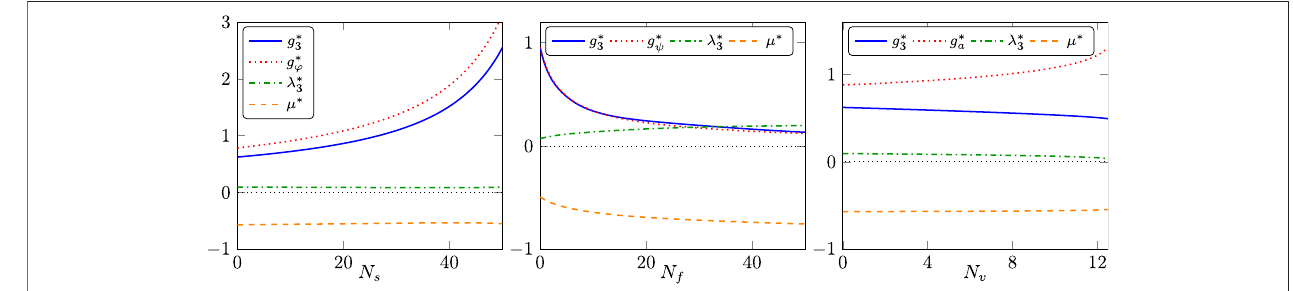
FIGURE9| Fixed-pointvaluesofthe fl uctuationcouplingsasafunctionofthenumberofscalar(left),fermion(middle),andgauge fi elds(right).Alltruncationsinclude thegravitontwo-andthree-pointfunctionaswellastherespectivegraviton – mattervertex.Inthescalarcase,theNewton couplings, g 3 and g φ ,aredivergingat N s ≈ 52. The fermionic caseisstable forall N f .Inthegauge fi eldcase, the fi xed pointisdisappearinginthecomplexplane at N v ≈ 13.Itwasexplainedin202thatthevanishingof the fi xedpoint isan artifactofthetruncation and howitcanbeliftedinthe gauge- fi eldcase. In97,itwassuggested thatanexpansionabout abackgroundthatisa solution to the quantum EoM might remove the divergence in the scalar case. The result are taken from 93 (scalar), 204, (fermion), and 202 (gauge).